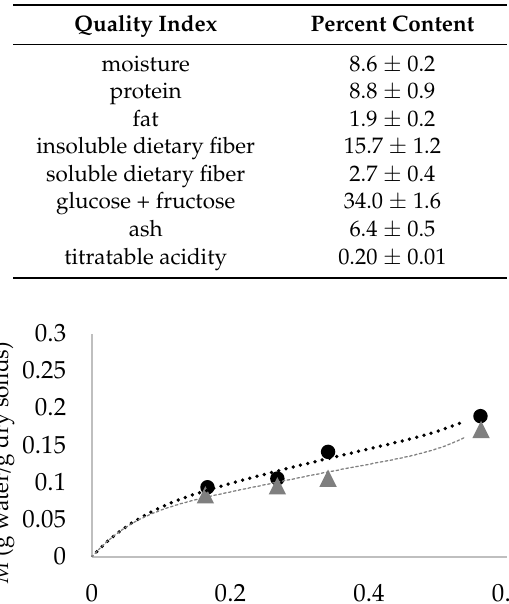
Table 1. Major components of tomato pulp powder (g/100 fresh weight.)